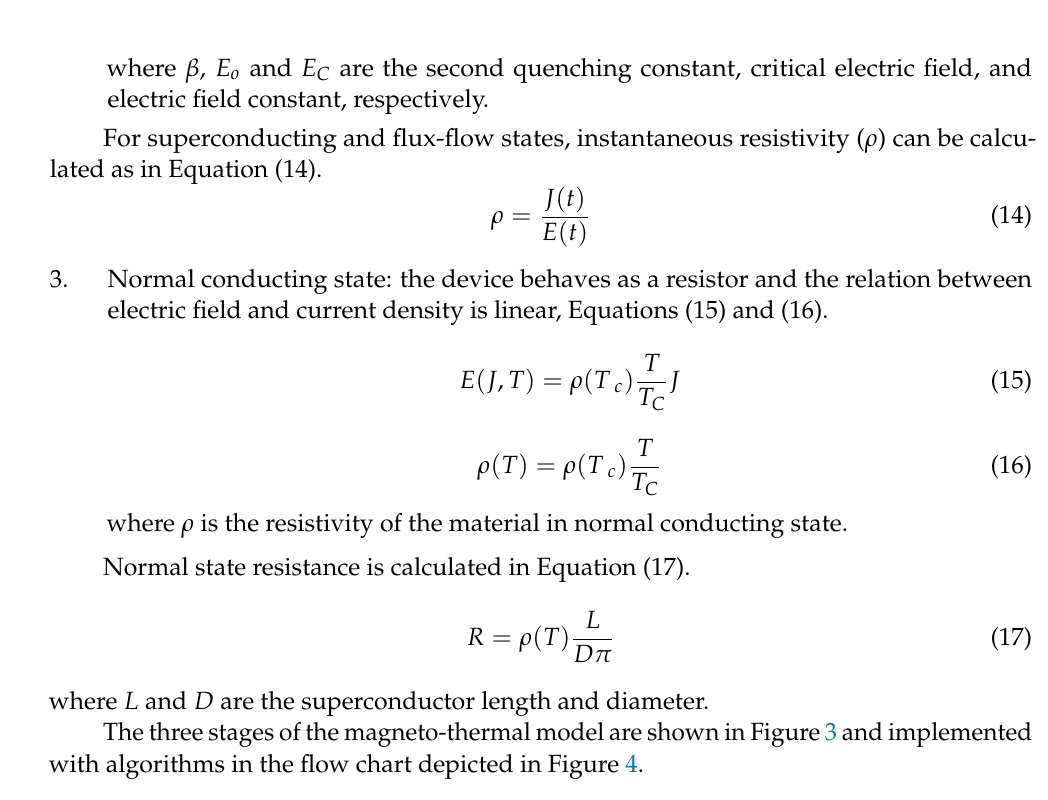
Figure 3. E-J characteristic of HTS material.